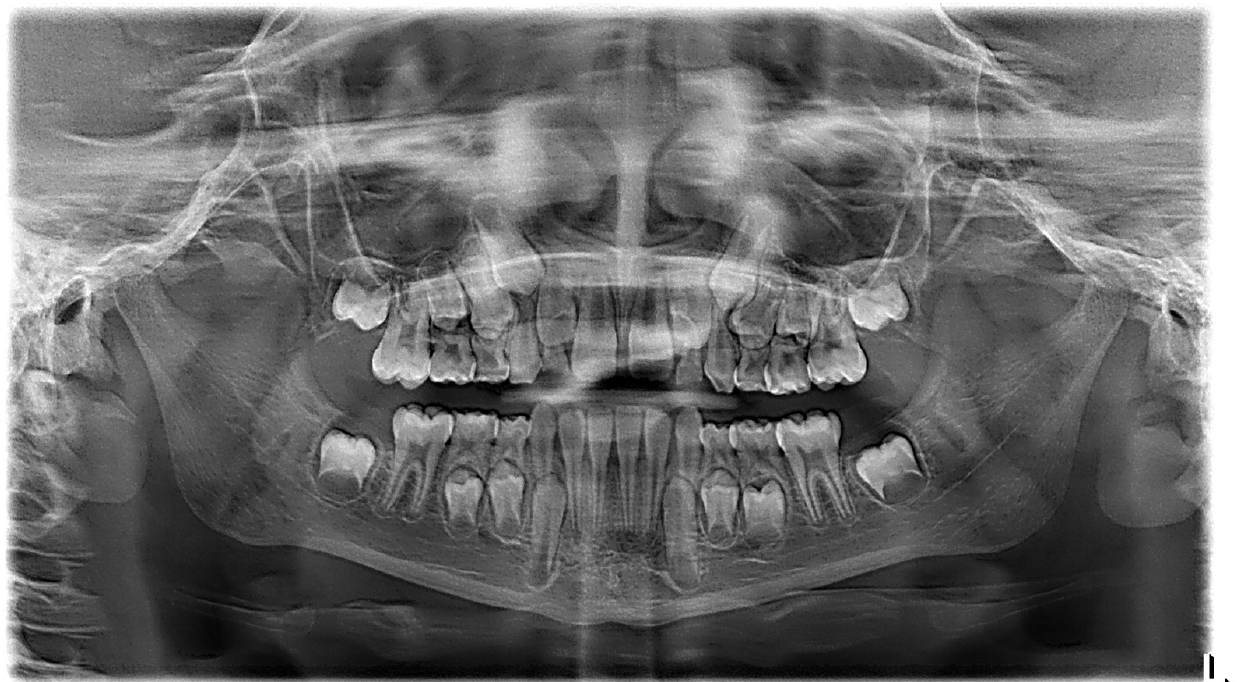
Figure 14. Radiographs of the patient at the screening. Orthopantomography X-ray before treatment (7-year-old).